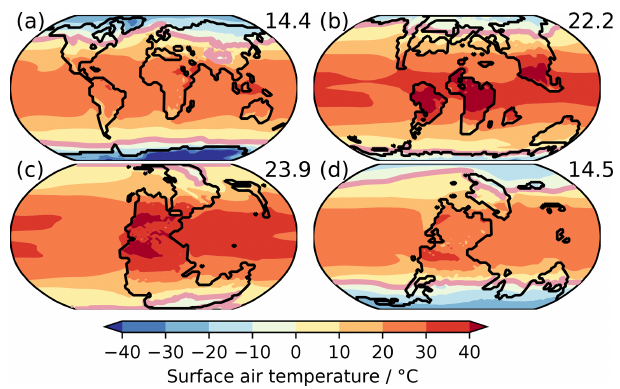
Figure 2. Annual average surface air temperature simulated in (a) PI-CM 21 , (b) Ma-CM 21 , (c) Wu-CM 21 and (d) As-CM 21 . Global-mean values are indicated in the top right. The 0 ◦ C isoline is indicated in pink. Continental outlines are indicated with a solid black line.